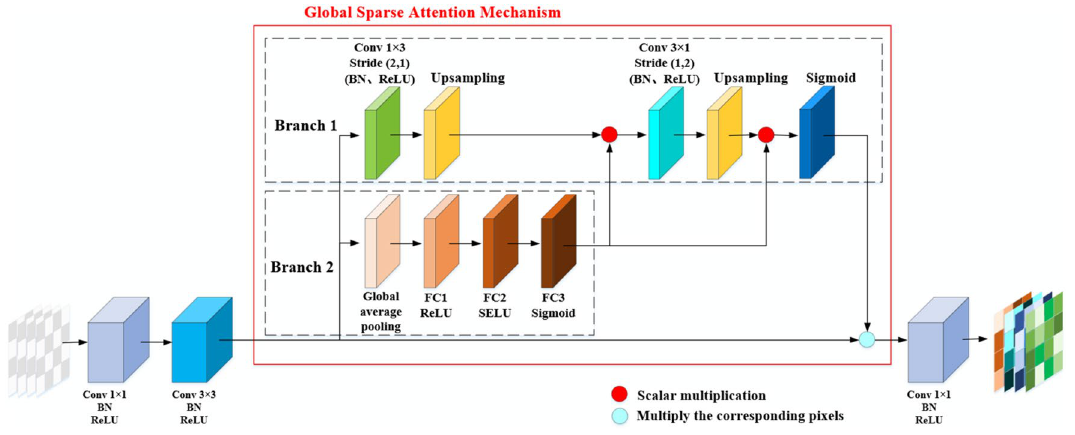
Figure 8. Global sparse attention